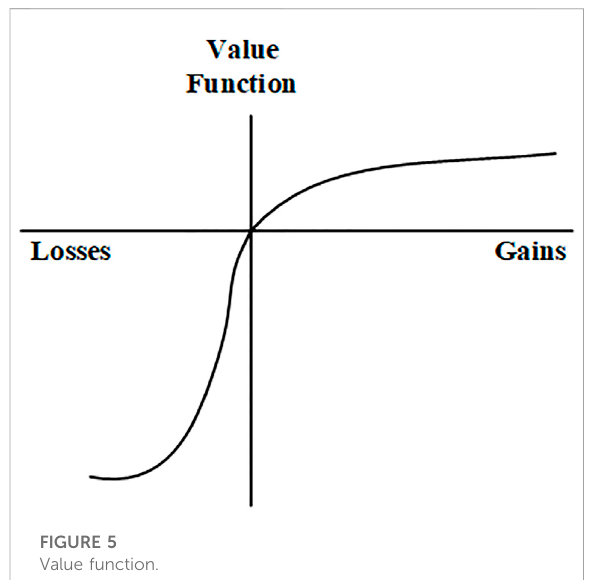
FIGURE 5 Value function.